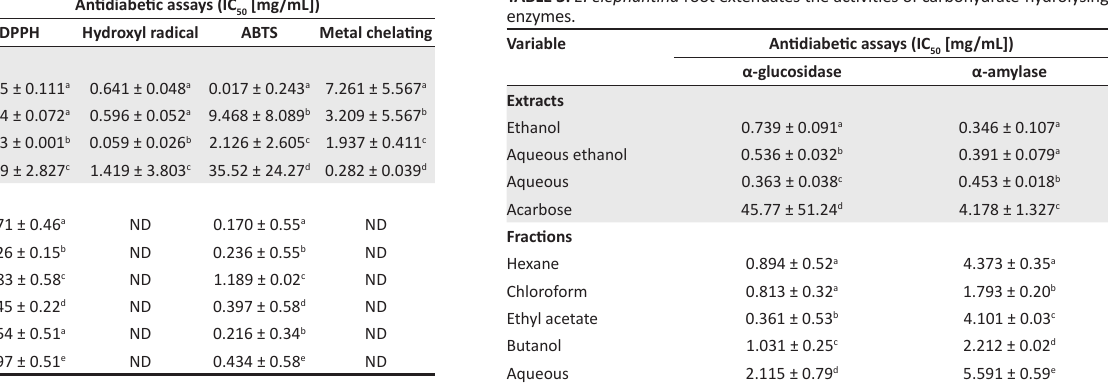
TABLE 2: Free radical scavenging and metal chelating abilities of different extracts and fractions of E. elephantina root. Variable TABLE 3: E. elephantina root extenuates the activities of carbohydrate-hydrolysing